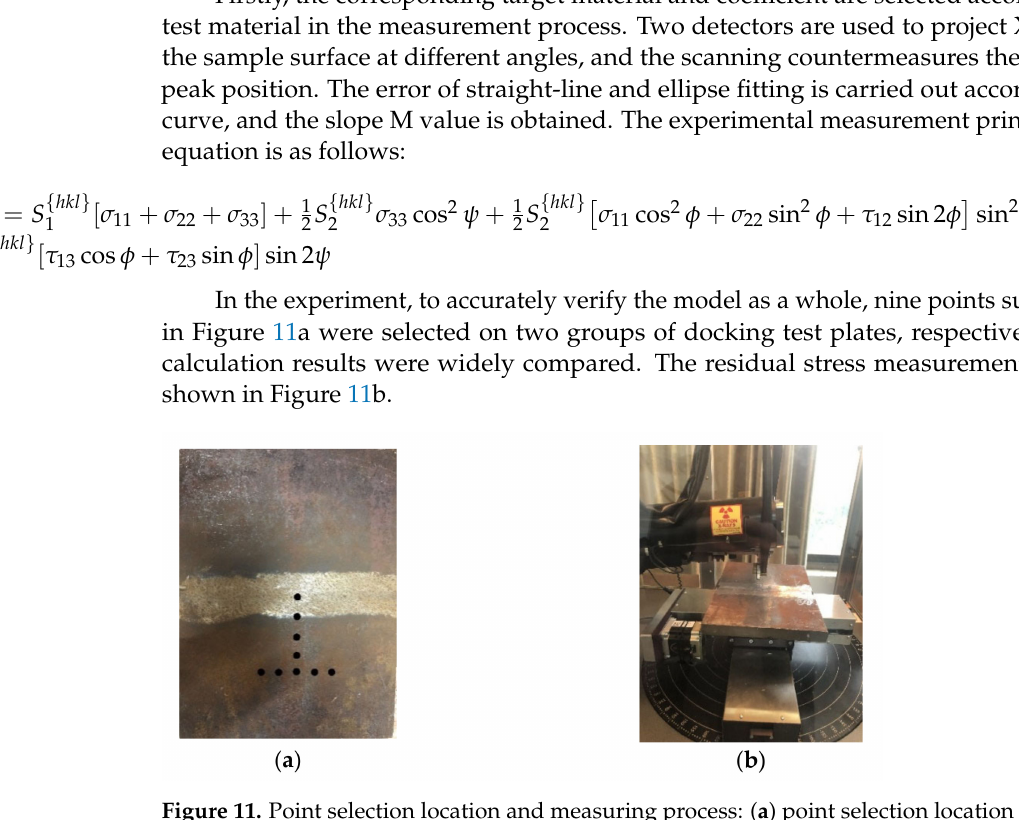
Figure 11. Point selection location and measuring process: ( a ) point selection location and ( b ) mea- suring